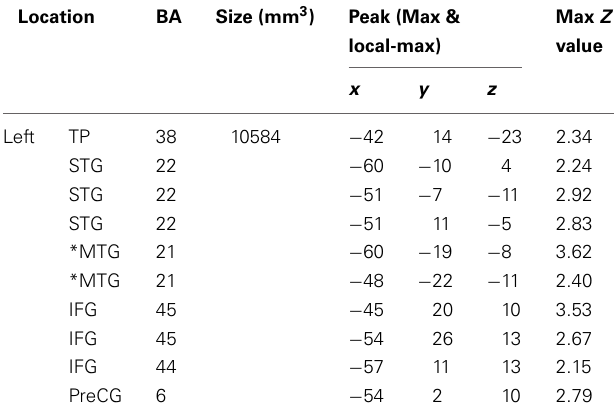
Table 2 | Random effects results from group 1 and group 2. Table 3 | Significantly active regions for word spelling for